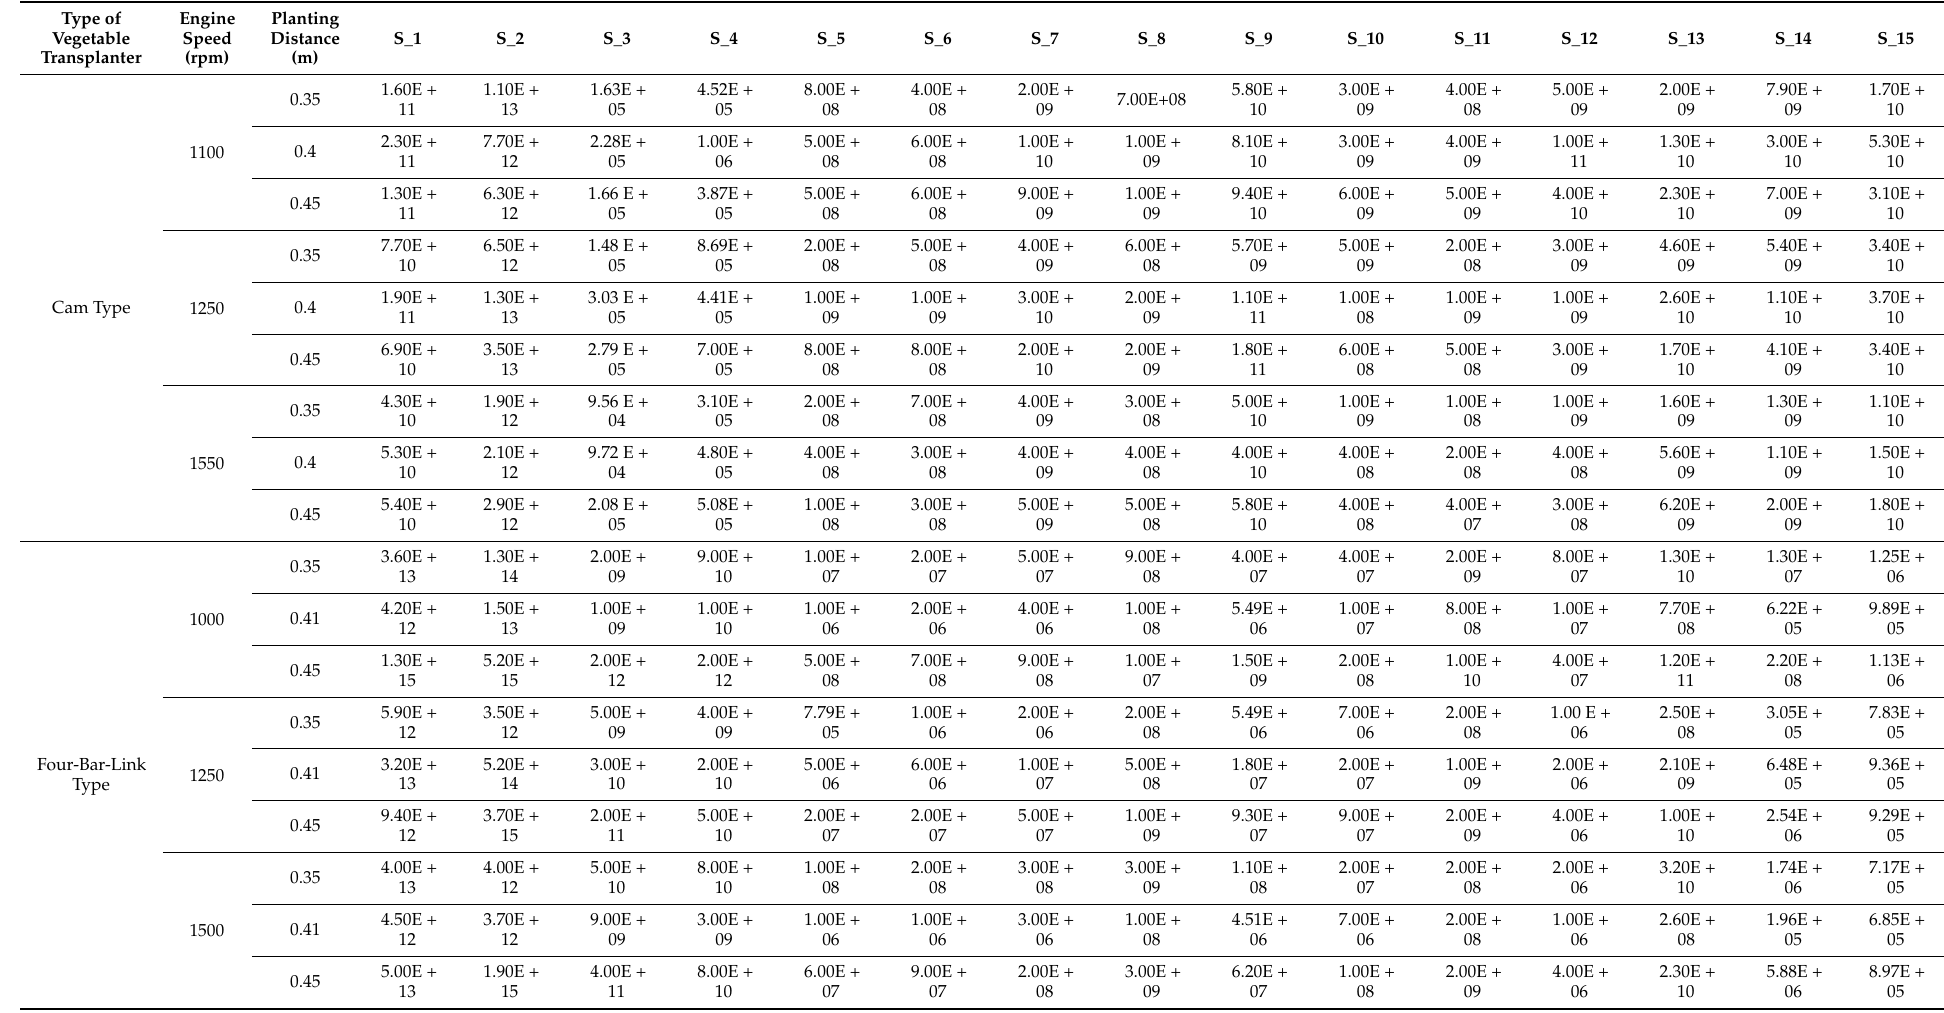
Table 6. Fatigue life (years) on every spot of strain gauge in cam and four-bar-link types of vegetable transplanters under each working condition. Type of